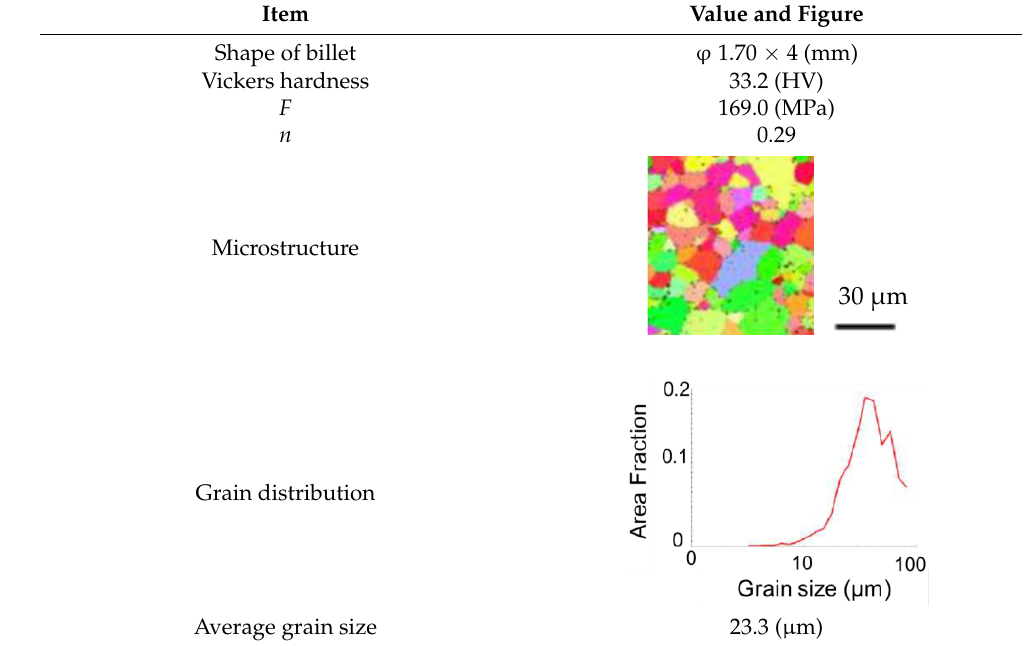
Table 1. Dimension and properties of the AA6063 billet [21].